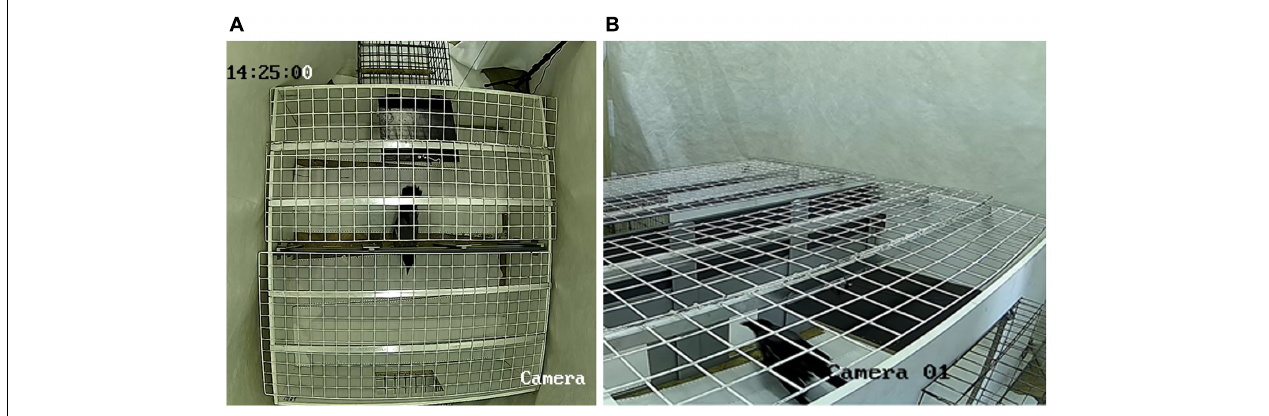
FIGURE 2 | The experimental setup configured for the second group of crows as viewed from the camera 1 (A) and camera 2 (B) .